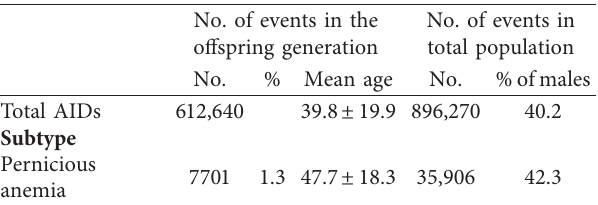
Table 1: Number of cases of autoimmune diseases in offspring ( N � 8.9 million) and in the total population,